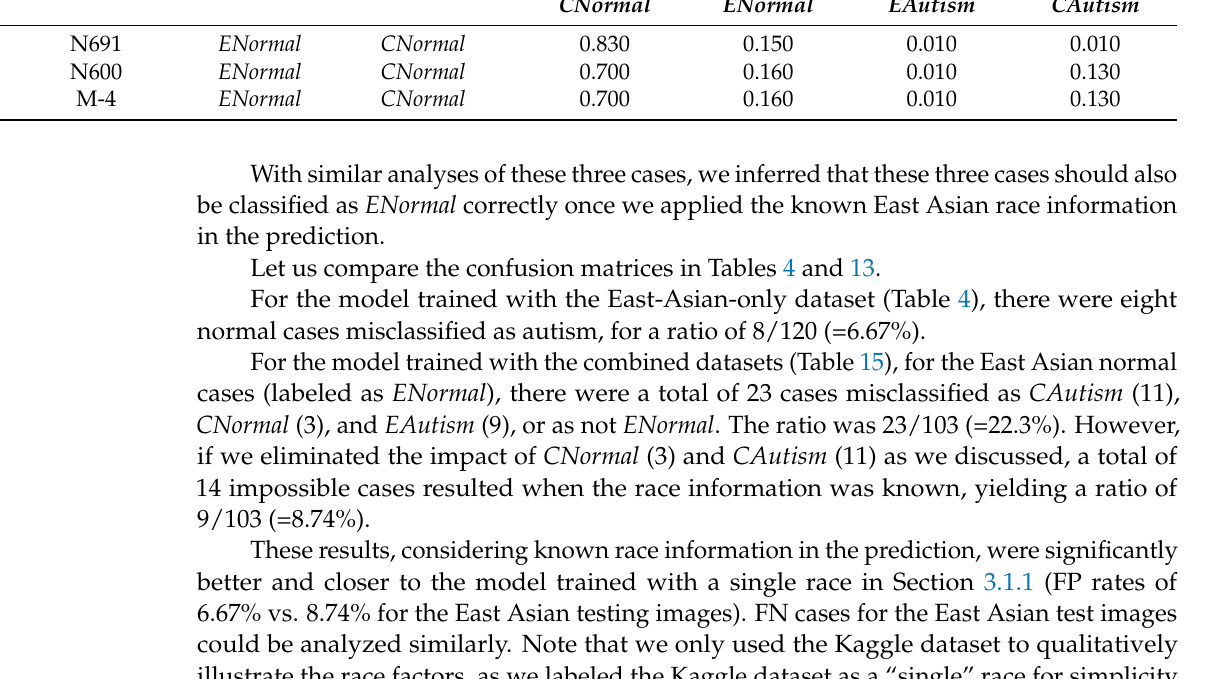
Table 15. Probability distribution for the four targeted classes for the three cases where ENormal was misclassified as CNormal . Test